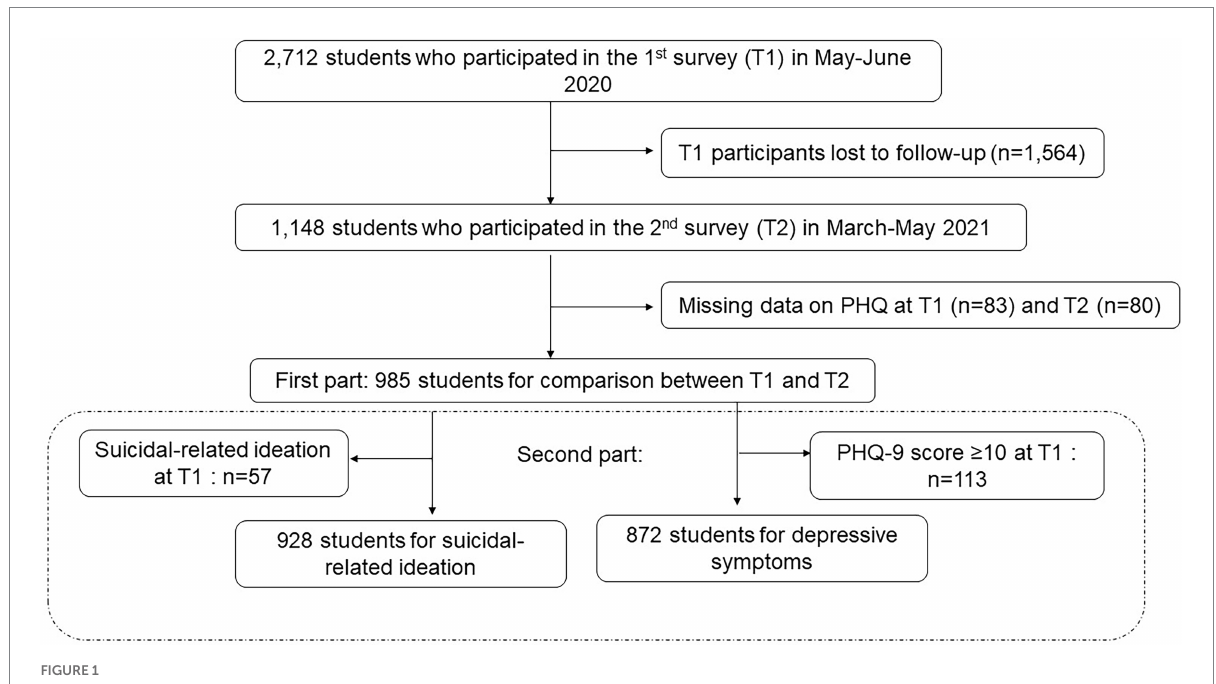
FIGURE 1 Study enrollment flow chart. Among 2,712 students who enrolled in the first survey ( T 1) and 1,982 students who participated in the second survey ( T 2), 1,148 students participated in T 1 and T 2. After excluding students, who did not answer the Patient Health Questionnaire (PHQ-9, n = 80 at T 1 and n = 83 at T 2), 985 students became subjects for comparison analyses for PHQ-9-based depressive symptoms between T 1 and T 2 (first part). For the second part, we excluded those who had moderate degrees of depressive symptoms ( n = 113) and suicidal ideation ( n = 57) at T 1 because these group of people were not at risk for developing the outcome. Accordingly, 928 students and 872 students became subjects for analyses to investigate factors associated with new onset of depressive symptoms and suicidal ideation during T 1 and T 2,